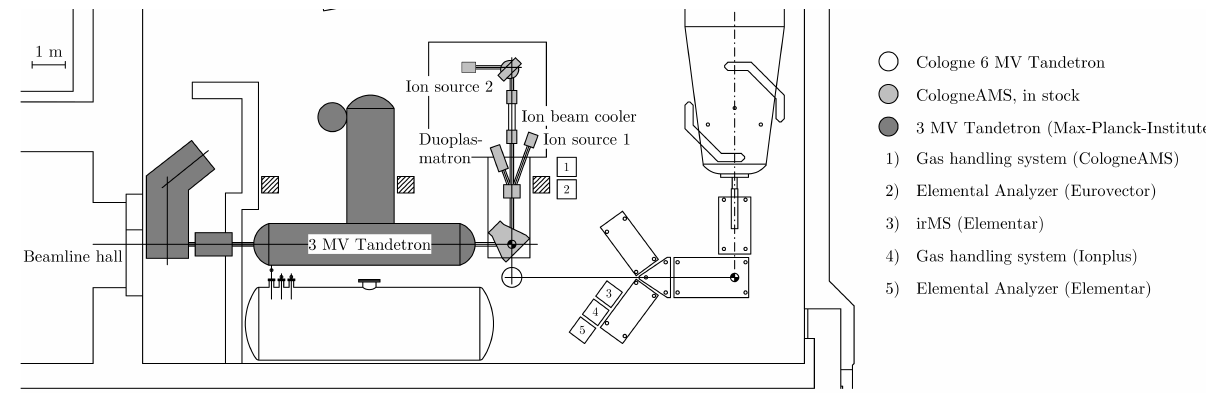
Figure 3. One possibility for the installation of the new 3 MV Tandetron accelerator in the second basement of the accelerator building of the Institute for Nuclear Physics of the University of Cologne. Shown are the new components from the MPI (dark gray) and the available components (light gray). Additional beamlines for future applications can be built up in the neighboring beamline